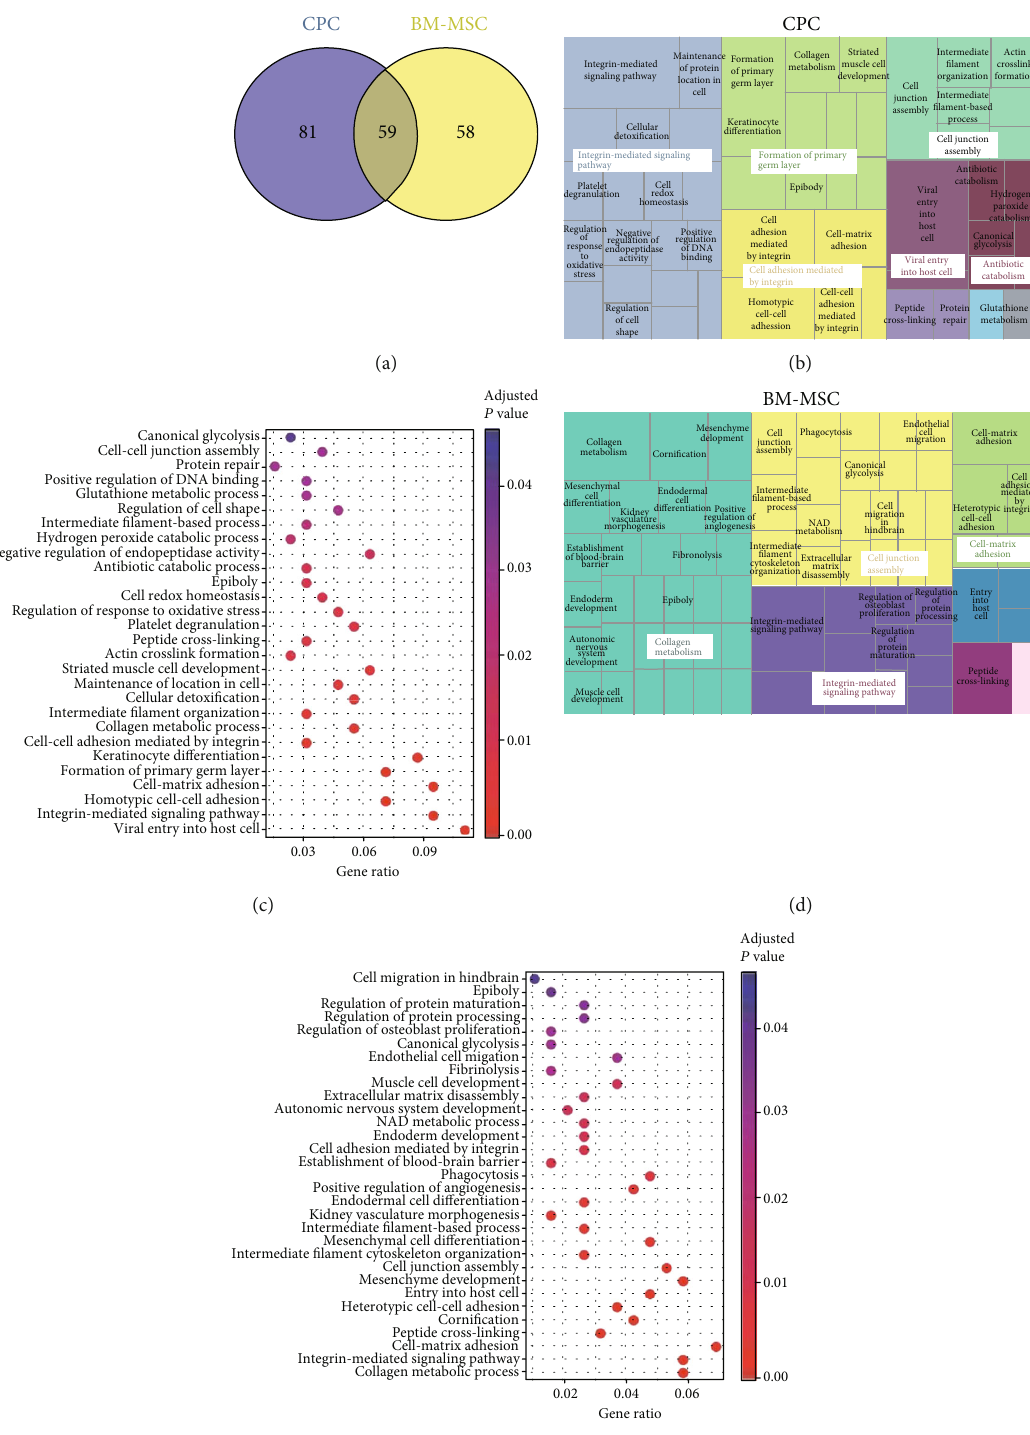
Figure 2: Graphical representation of upregulated GO biological processes identi fi ed by proteomic analysis in CPCs and BM-MSCs. (a) Venn diagram of data from proteomic analysis of membrane fractions, 140 proteins were expressed in CPCs, 117 were expressed in BM-MSCs, and 59 proteins were commonly expressed in both cell types. (b) Treemap diagram of biological processes overrepresented in cardiac-derived stromal cells using REVIGO webtool after proteomic analysis. (c) Dotplot representing GO biological processes overrepresented in CPCs. (d) Treemap diagram of biological processes signi fi cantly overrepresented in bone marrow mesenchymal stem cells using REVIGO webtool after proteomic analysis. (e) Dotplot representing GO biological processes signi fi cantly overrepresented in